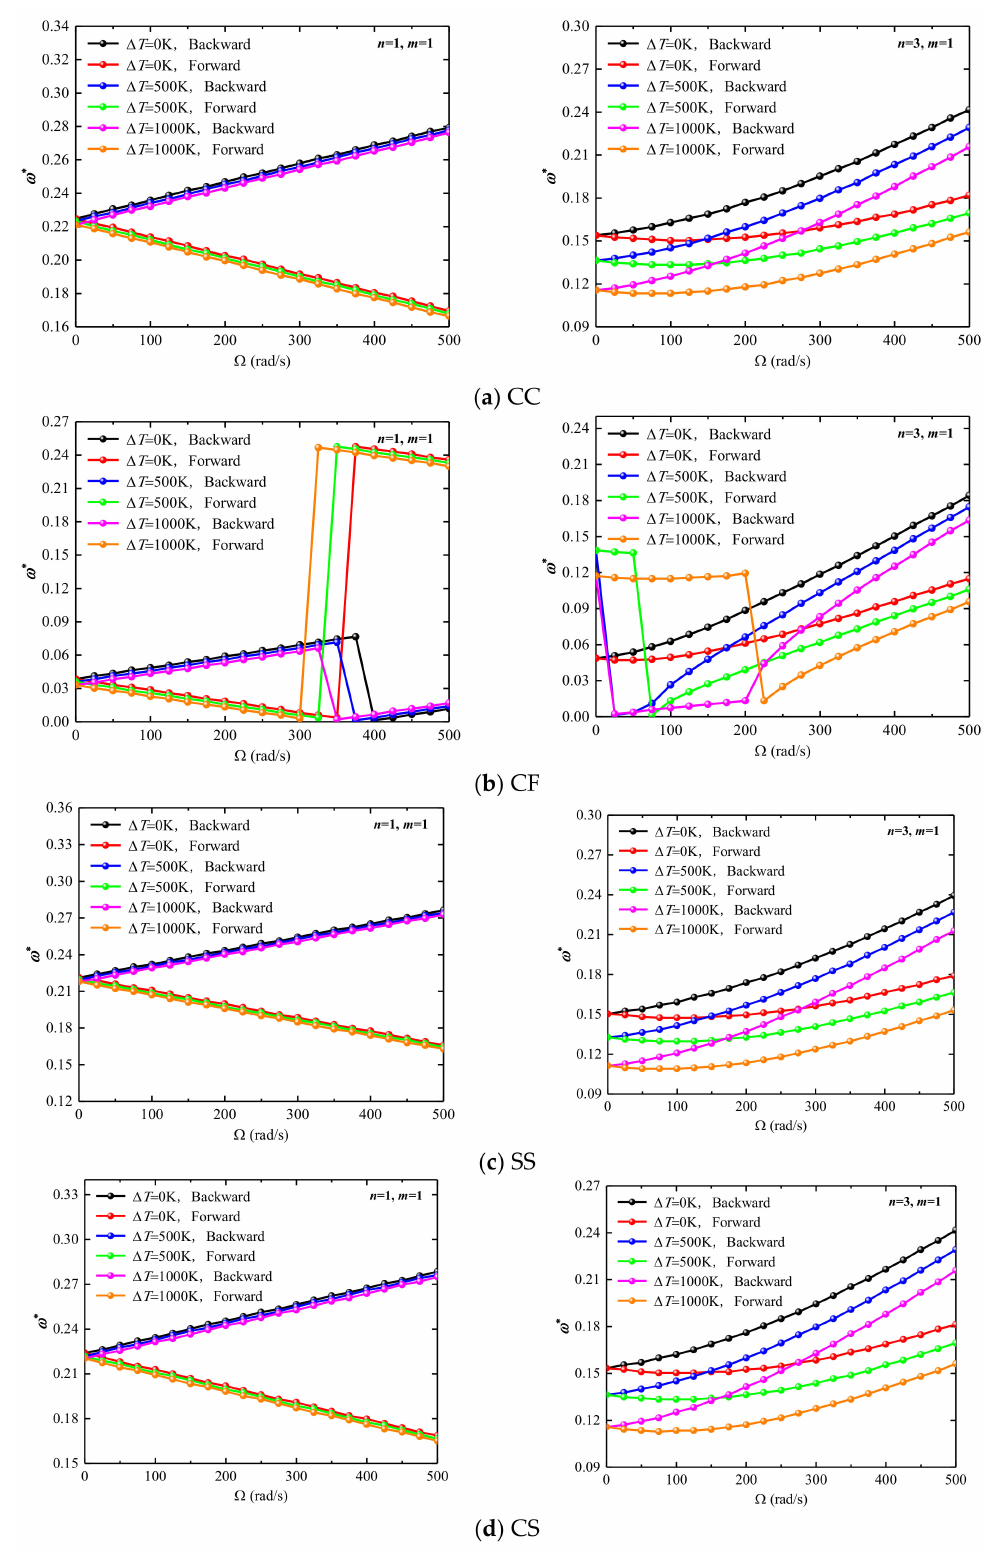
Figure 6. Variation of dimensionless frequencies ω ∗ of rotating laminated combined conical- cylindrical shell in the thermal